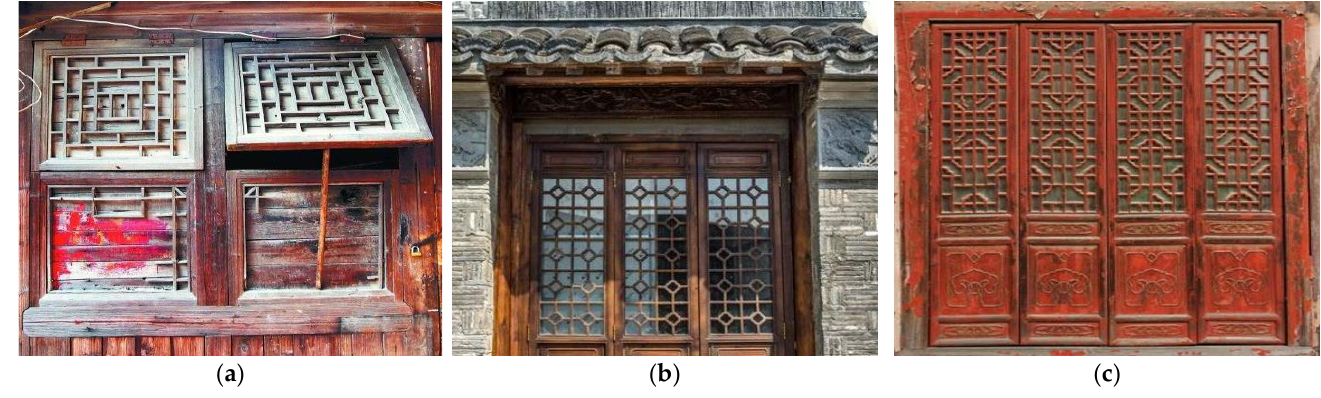
Figure 10. Doors and windows of traditional buildings in Guangdong.